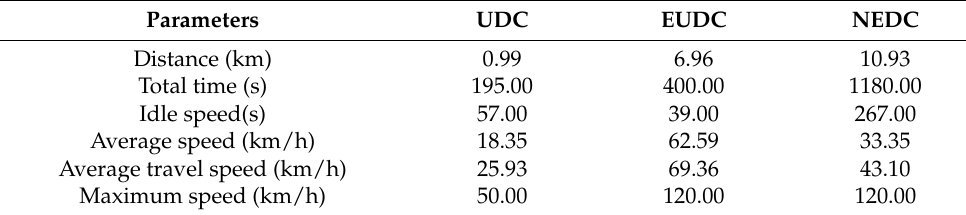
Table 2. Test cycles before the introduction of WLTP.